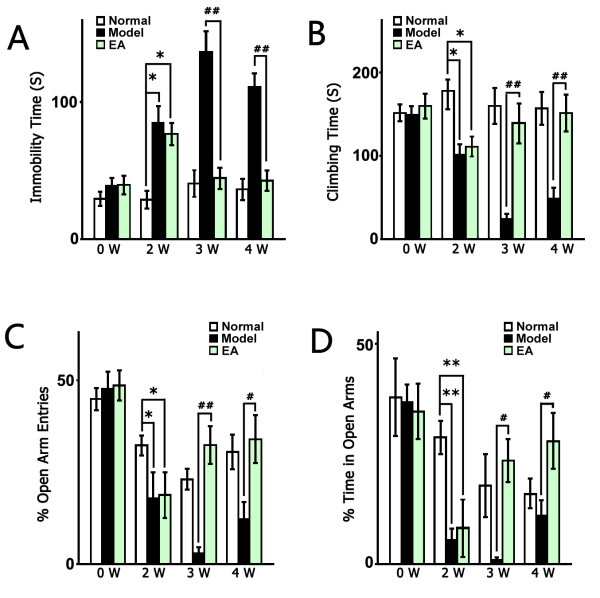
EA reversed the depressive-like behavior of the stressed rats. The normal group underwent no stress; the Model group received the chronic unpredictable stress (CUS) for 4 weeks; the EA group received CUS for 4 weeks, as well as EA treatment for the latter part of the CUS (2 weeks). (A) The immobility times in the forced swimming test (FST) decreased after 3 and 4 weeks of CUS (1 or 2 weeks of treatment) in the EA group compared with the Model group. (B) The climbing time in the FST was reversed to normal levels by EA treatment. (C) &(D) The percentage of open-arms entries and open-arms time in the elevated plus maze (EPM). The values are presented as the mean ± SE, n = 8 or 18 in each group. Significance of “Model vs Normal” is marked by * (P <0.05) or ** (P <0.01), and that of “EA vs. Model” is marked by # (P <0.05) or ## (P <0.01).